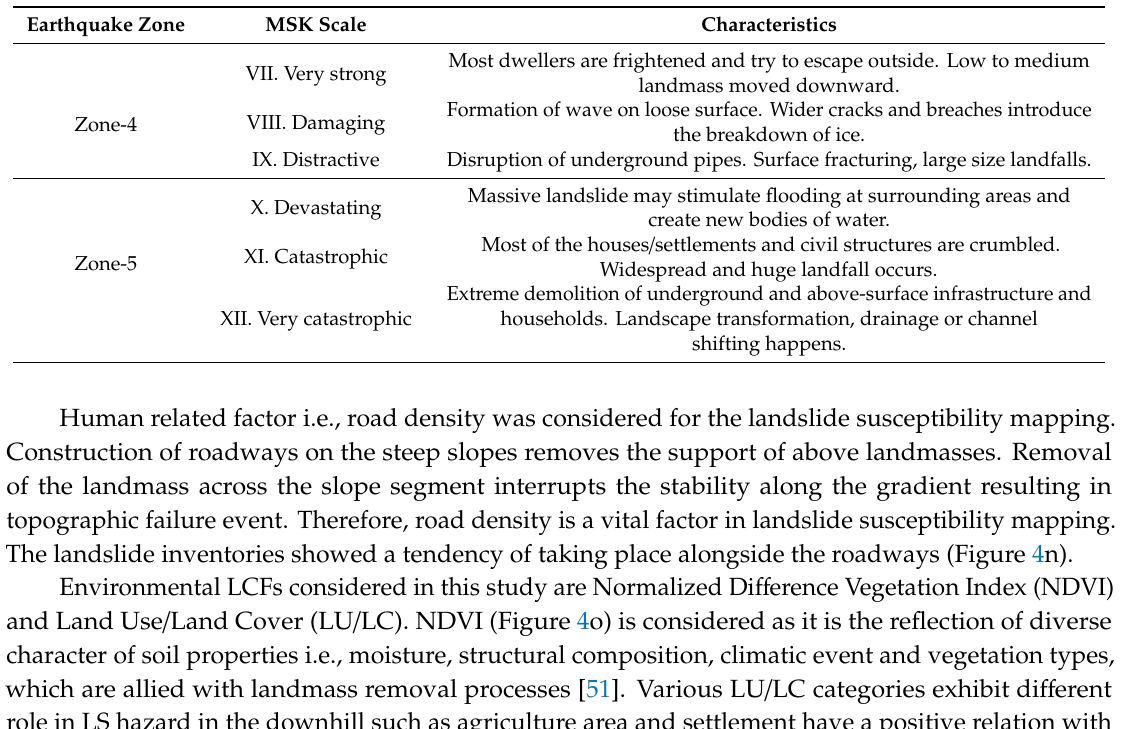
Table 2. Earthquake zonation based on Medvedev–Sponheuer–Karnik (MSK)